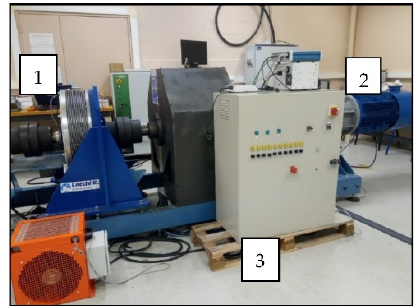
Figure 6. Experimental test bench.